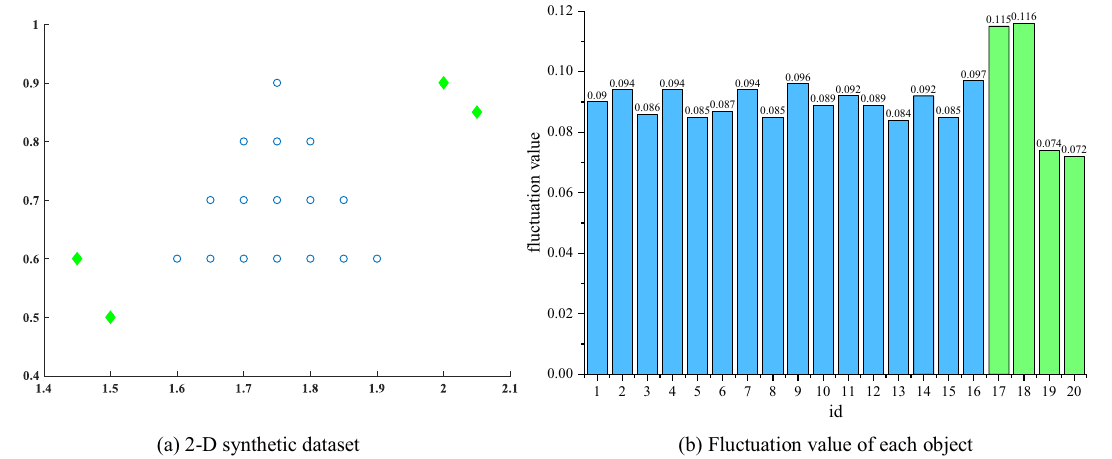
Figure 6. 2D synthetic dataset and fluctuation value of each object. Sixteen normal objects are represented by blue hollow circles, and four outlier points are represented by solid green